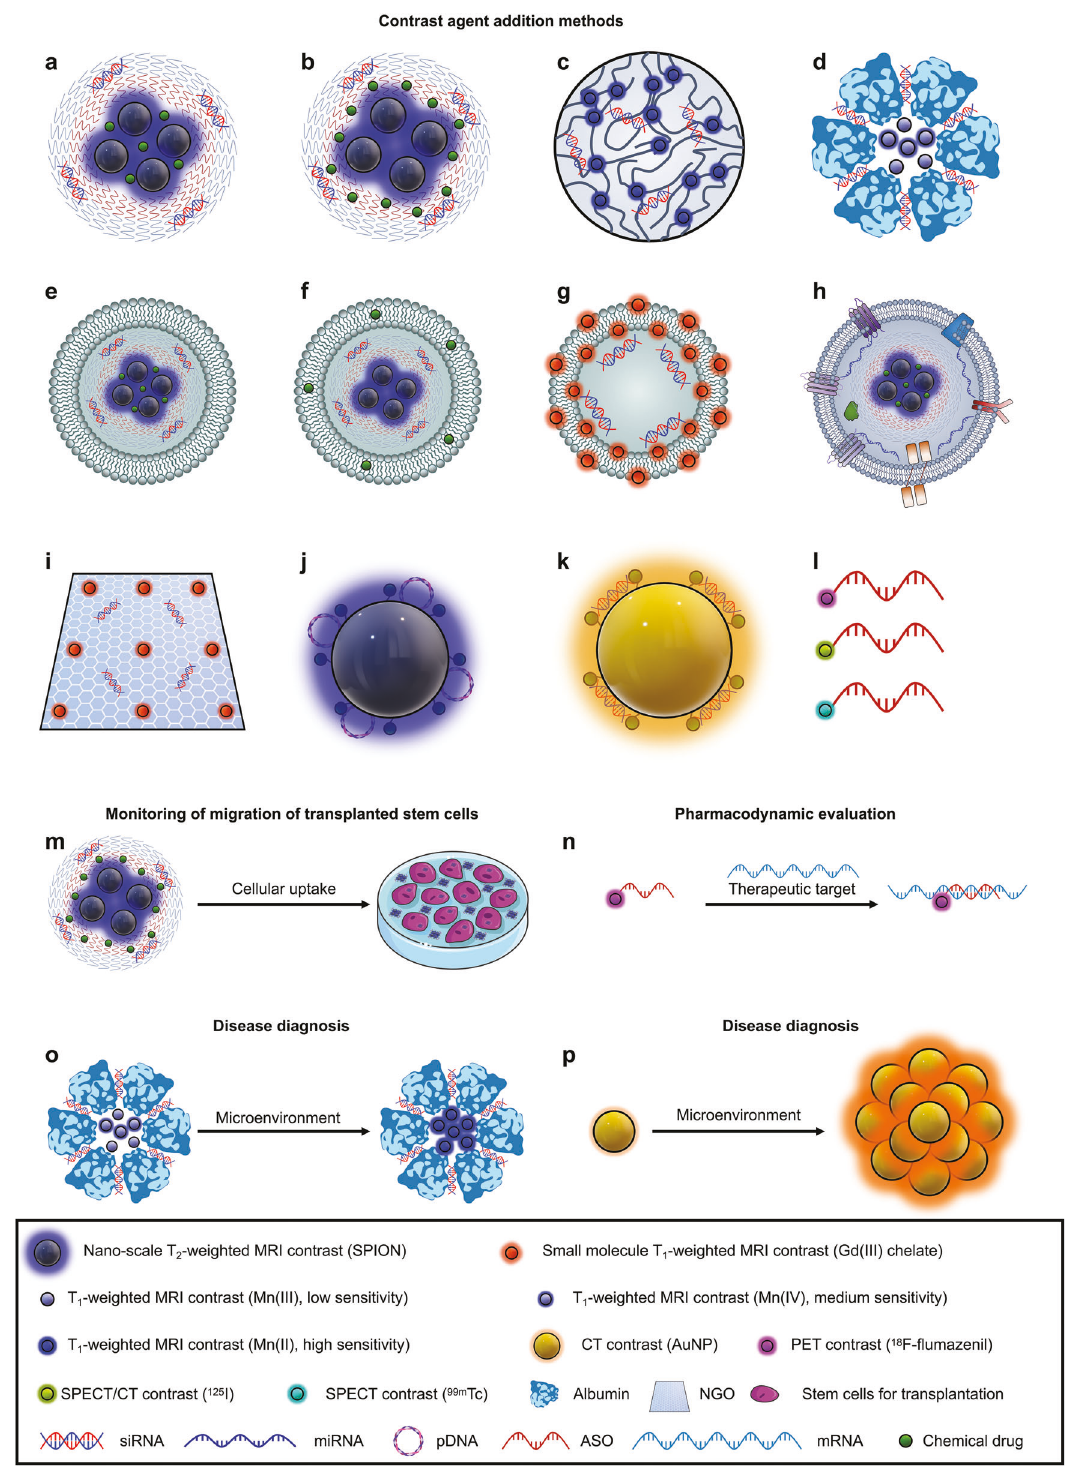
in fl uencing factors, such as proton density-weighted MRI, T 1 - weighted MRI, and T 2 -weighted MRI. MRI provides many advan- tages applicable to brain disease diagnosis, such as high contrast and high spatial resolution that can distinguish different brain regions, non-invasive and safe imaging, and multi-parametric&se- quence imaging that can provide more diagnostic information, thus becoming the preferred medical imaging tool for the clinical diagnosis of brain diseases. Signal Transduction and Targeted Therapy (2023)